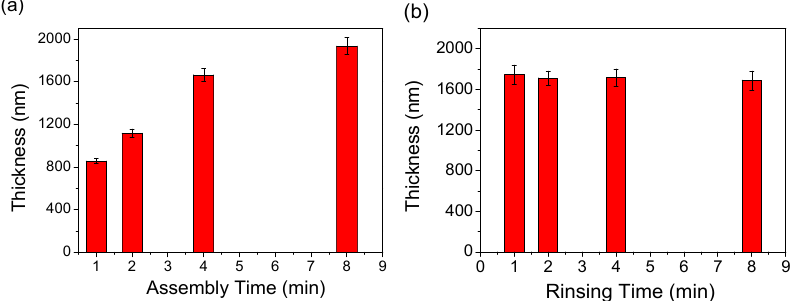
Figure 3. Thickness of (PEOX/PAA) 20 film: ( a ) the film prepared with different assembling time, rinsing time fixed to be 1 min; ( b ) different rinsing time, assembling time fixed to be 4 min. (PEOX, M w 50,000, 1 mg/mL; PAA, M w 450,000, 1 mg/mL; pH 2.0; and room temperature).